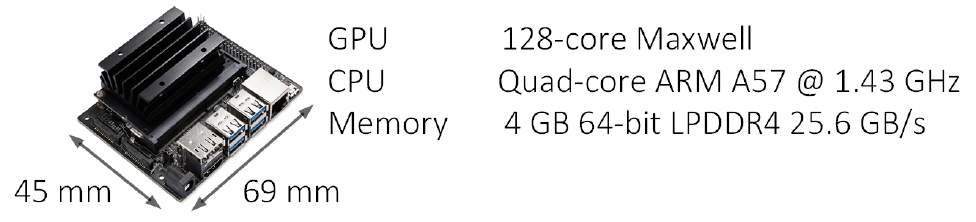
Figure 7. NVIDIA Jetson size and specification.